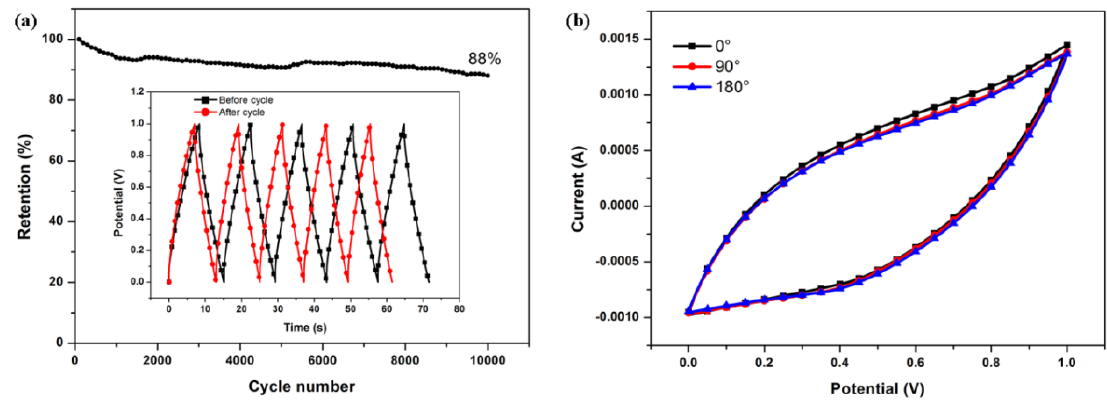
Figure 7. Electrochemical performance of ACF-10.3% PDPP-based symmetric supercapacitor: ( a ) long-term cycle stability test at a current density of 10 A·g −1 ; ( b ) CV curves of ACF-10.3% PDPP bended by different angles (0°, 90° and 180°) at a scan rate of 100 mV·s −1 ; and ( c ) digital photo images of a red LED powered by three devices in